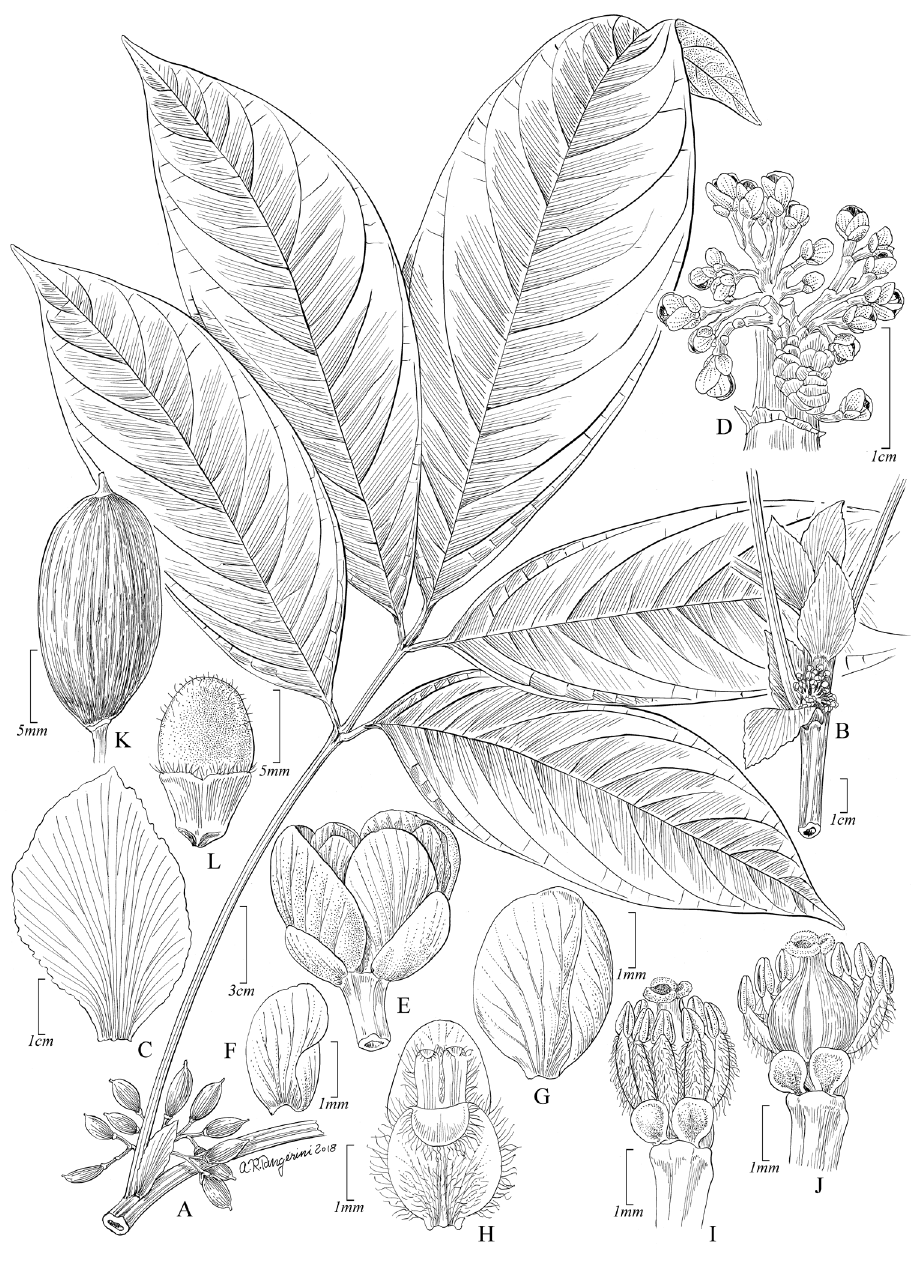
Figure 3. Paullinia fruticosa . A Fruiting branch B Detail of stems with stipules and axillary inflorescence C Posterior petal, dorsal view D Detail of inflorescence E Pistillate flower, lateral view F Outer sepal, frontal view G Posterior sepal, frontal view H Posterior petal with appendage, frontal view I Pistillate flower with removed perianth showing nectary lobes and staminodes, posterior view J Pistillate flower with removed perianth and some staminodes, showing nectary lobes and ovary, posterior view K Fruit L Seed, ventral view. A from Foster et al 11693 (US) B, D–L from Killip & Smith 27876 (US) C from Klug 4200